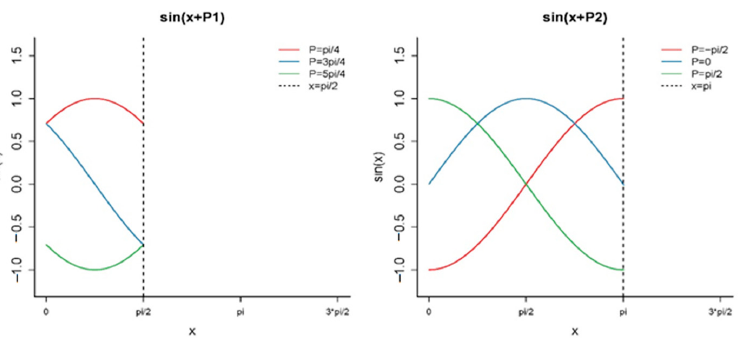
Figure 4. Curves of sin(cid:4672)𝑥 + 𝑃 (cid:3047)((cid:3036)) (cid:4673) for different phase values. The left (right) column indicates possible shapes for the Fourier series before (after) the splitting age. The parts on the left of the two black dashed (vertical) lines in the left and right plots denote the shape of a quarter and half of a complete cycle, respectively.